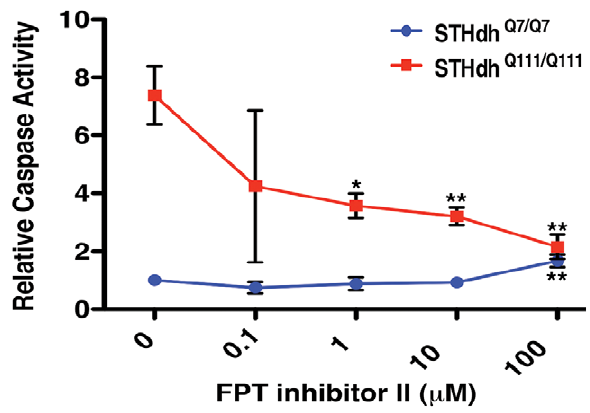
Figure 8. Small Molecule Inhibition of Farnesyltransferase Rescues Toxicity in an HD Cell Model. The farnesyltransferase inhibitor FPT inhibitor II rescues mutant Htt toxicity in ST Hdh Q111/Q111 cells in a dose-dependent manner (n= 3). *p , 0.05, **p , 0.01, ***p , 0.001, ANOVA with Tukey’s Multiple Comparison Test.